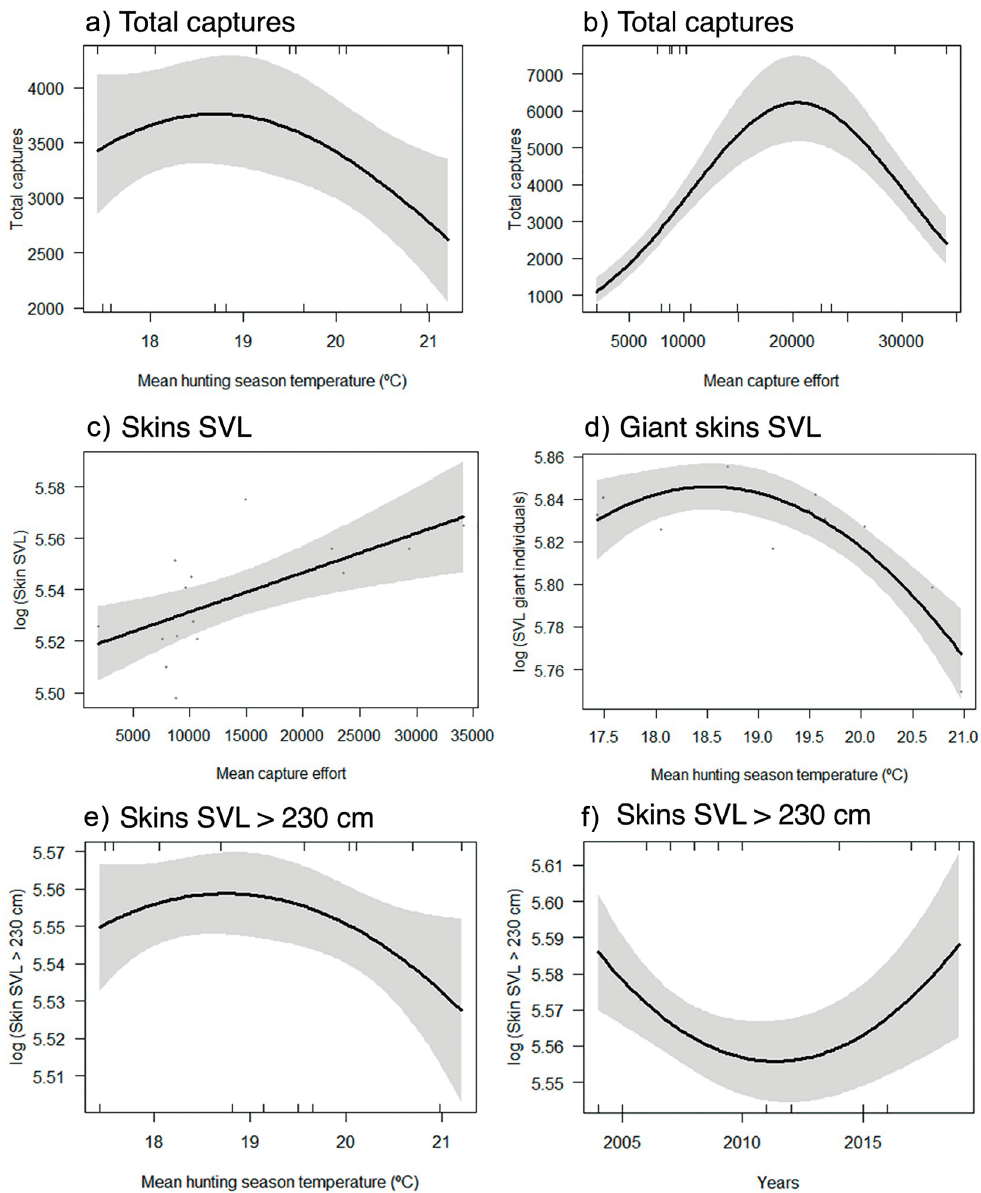
Fig 5. Effects of the explanatory variables on the parameters of the population of yellow anacondas ( Eunectes notaeus ) harvested by the Programa Curiyú between 2004–2019 in northeastern Argentina. Models selected based on the lowest AIC values are shown. The grey area indicates the 95% confidence